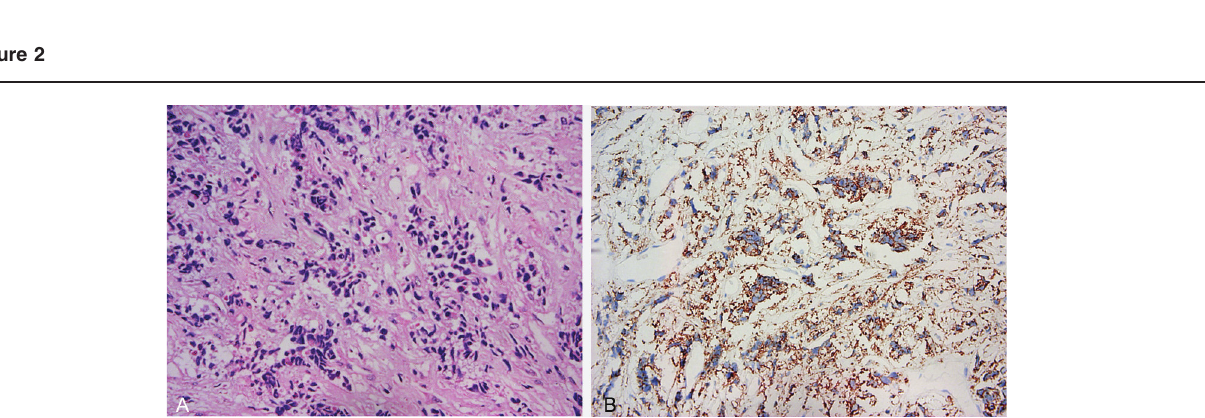
A: Histopathology slide shows markedly cellular tumor composed of malignant round cells with relatively monomorphic round nuclei. The cytoplasm ranged from abundant clear to scanty eosinophilic. Sheets of tumor tissue showed focal apoptosis and necrosis with intervening fibrocollagenous stroma (H&E). B: Immunostaining using CD99 antibody shows strong continuous cell membrane